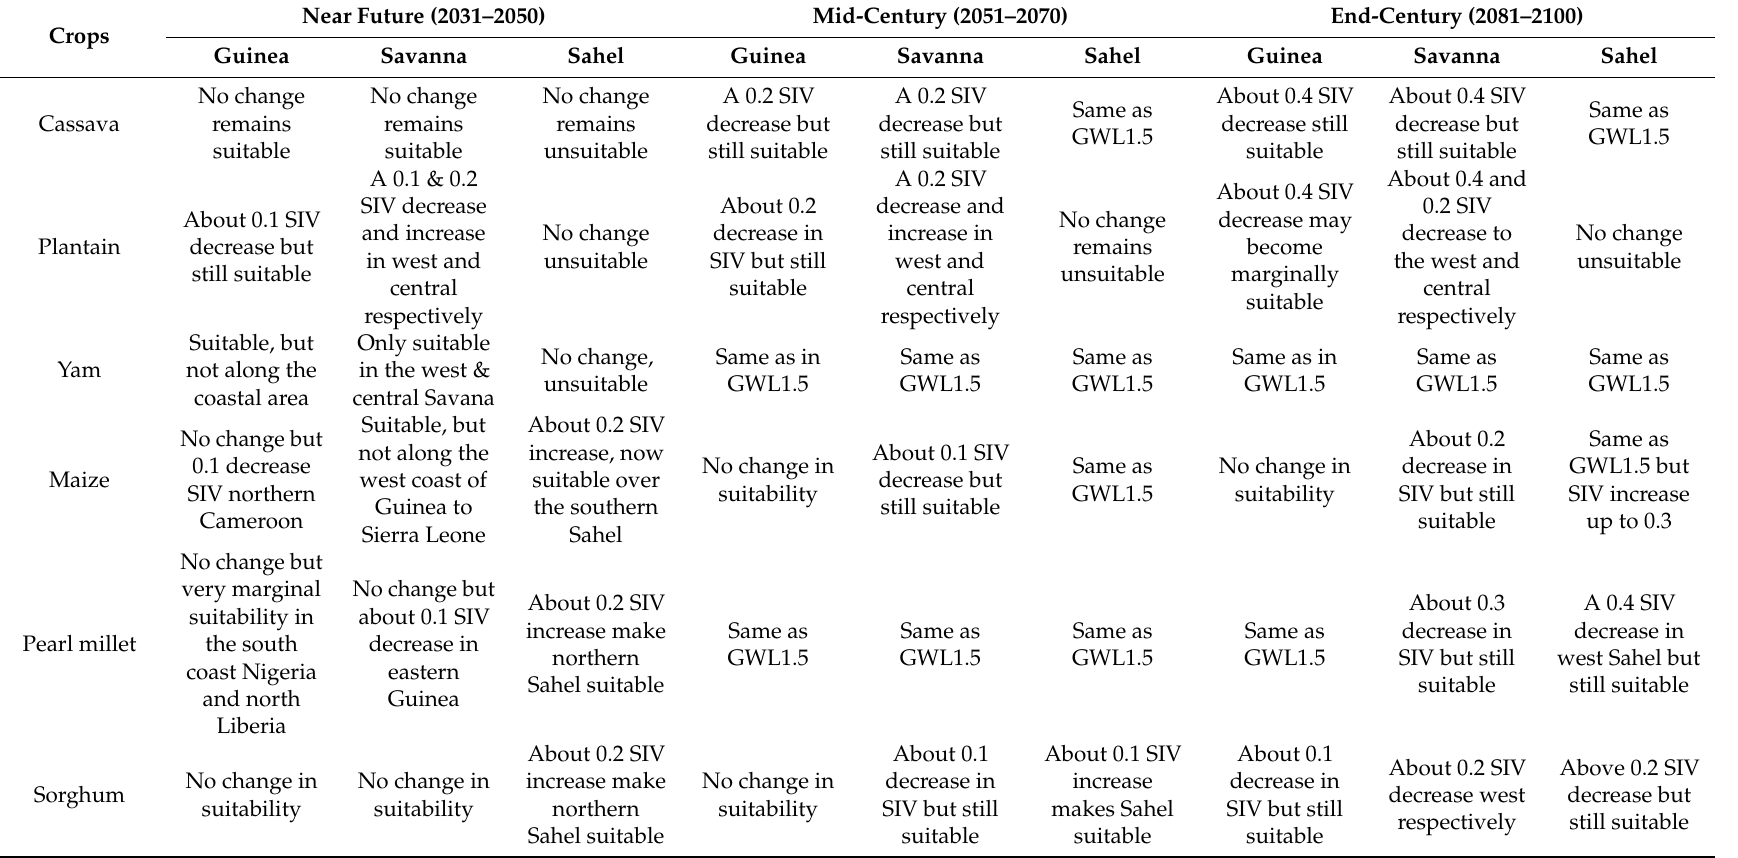
Table 2. Projected changes in crop suitability over West African AEZs at di ff erent future window